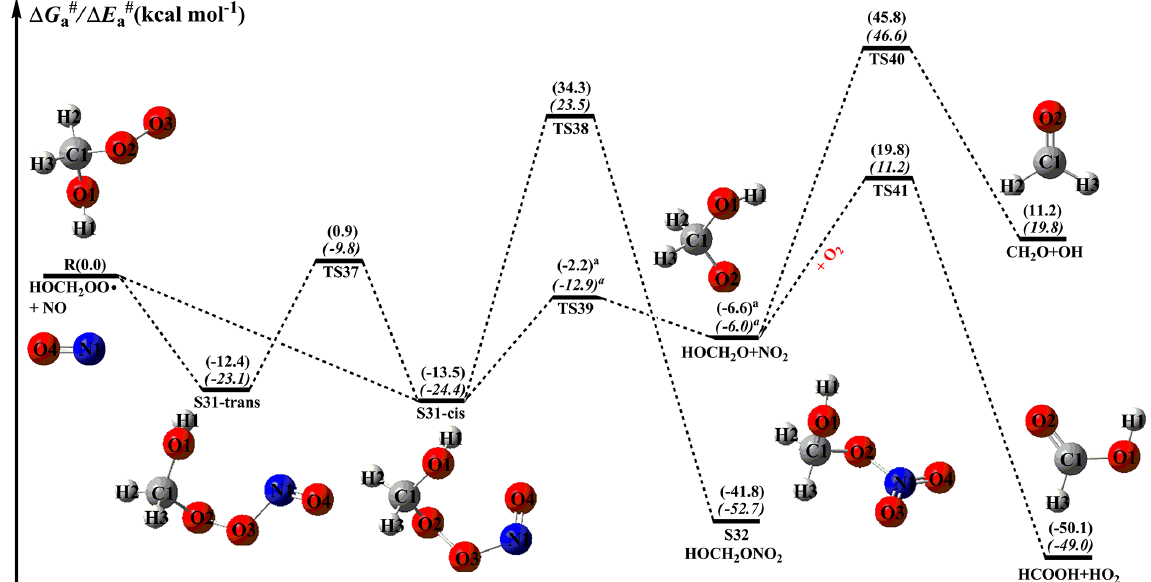
Figure 10. PES ( (cid:49)G # a and (cid:49)E # a , in italics) for the reaction of an HOCH 2 OO radical with NO predicted at the M06-2X/ma-TZVP//M06- 2X/6-311+G(2df,2p) level of theory (the superscript a is calculated at the MP2/ma-TZVP//MP2/6-311+G(2df,2p) level).